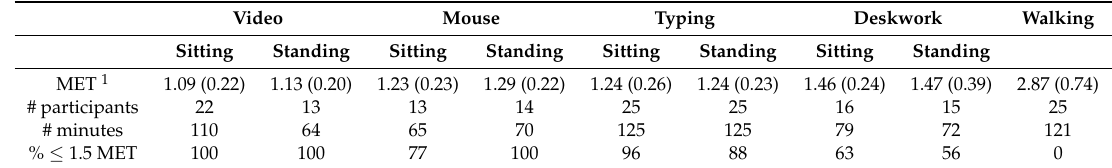
Table 3. MET value for each task, with number of participants per task (# participants), number of minutes per task (# minutes), and percentage of time spent ≤ 1.5 MET (either sedentary behavior or inactive